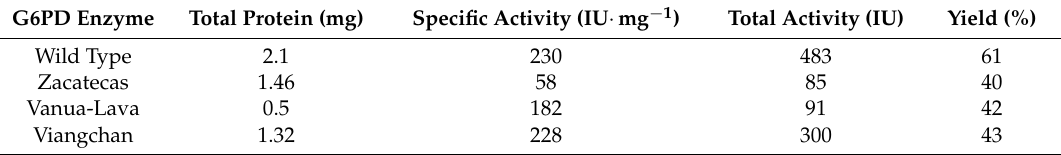
Table 1. Purification summary of all recombinant human glucose-6-phosphate dehydrogenase (G6PD) enzymes.